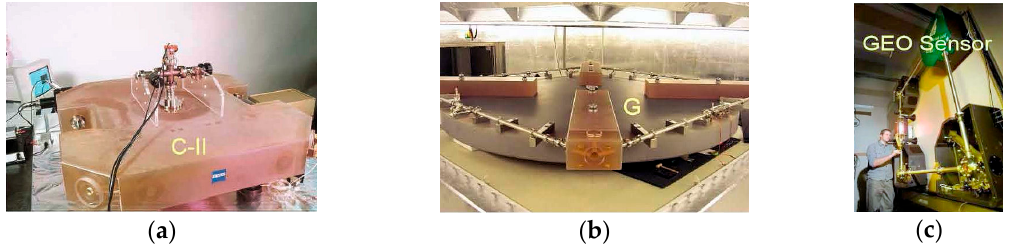
Figure 8. The ring laser rotational seismometer [84]: ( a ) C-II, horizontally installed; ( b ) G, horizontally installed; ( c ) GEO, vertically installed.